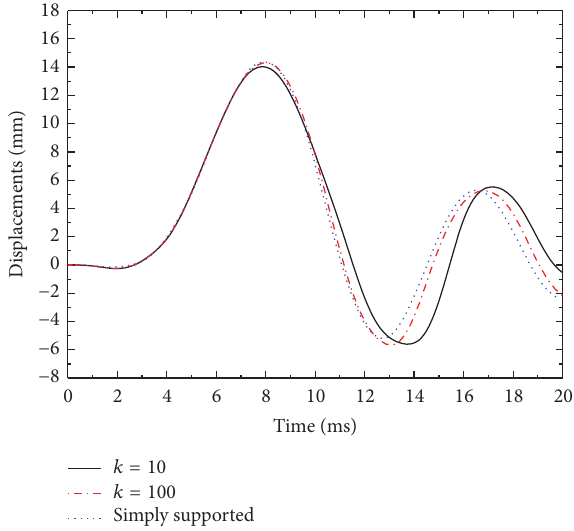
Figure 9: Transverse displacement history at the center point with different